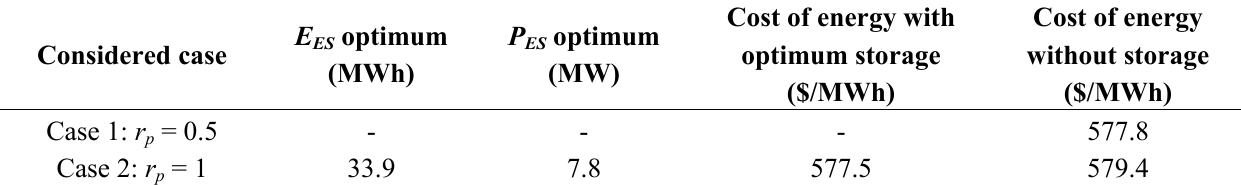
Table 2. Results of the energy storage optimization considering the standard operation strategy for traditional diesel generators ( P power penetration.